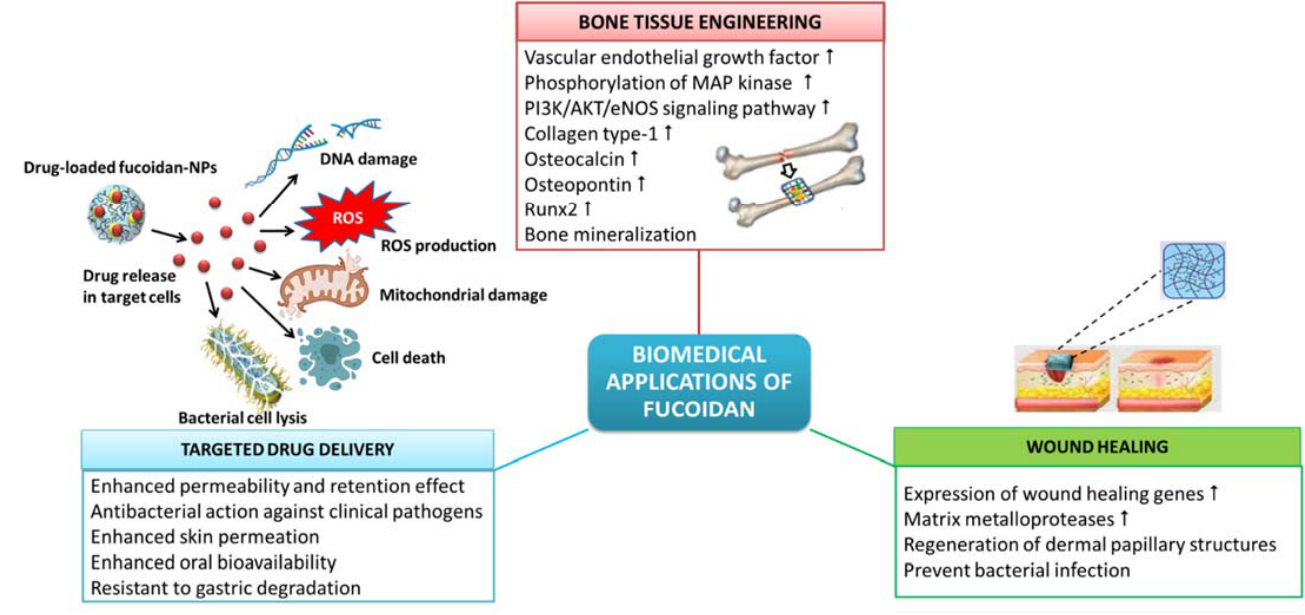
Figure 4. Biomedical applications of fucoidan .